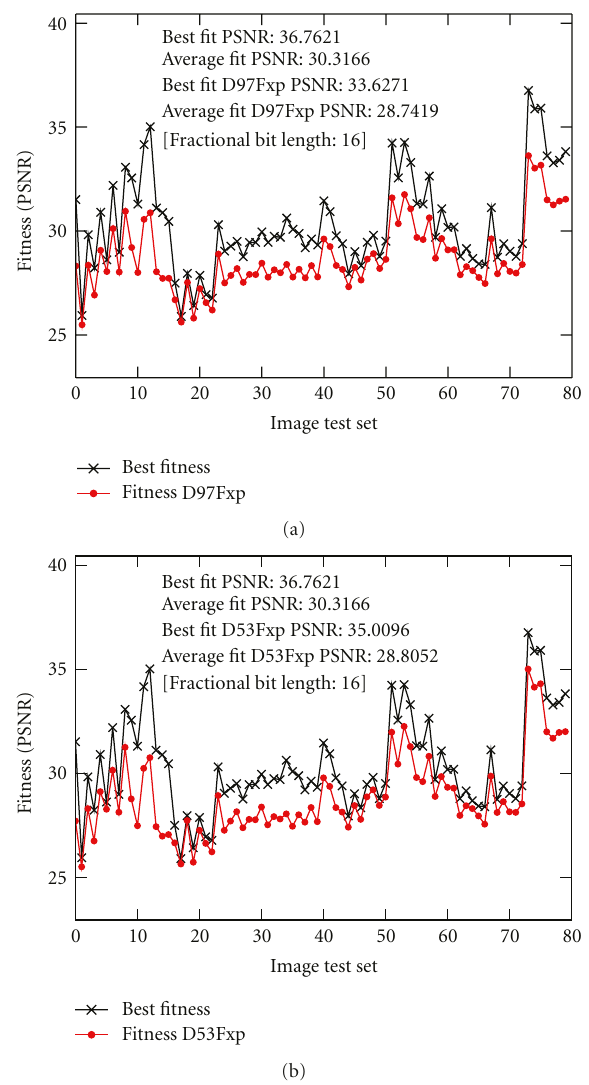
Figure 15: Performance of the best evolved individual for fixed point arithmetic and uniform mutation ( plus selection) against the whole test set: (a) comparison with D9/7 and (b) comparison with D5/3 wavelets.